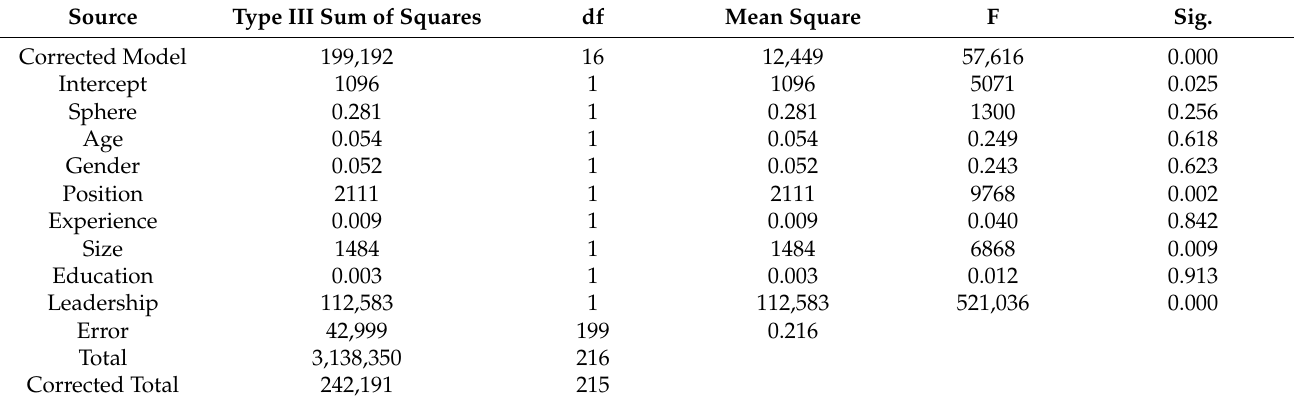
Table 4. Tests of Between-Subjects Effects. Source: authors’